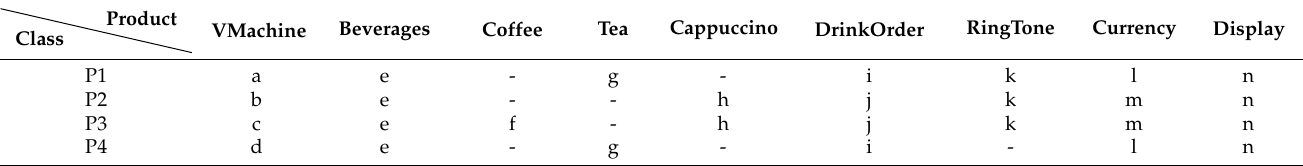
Table 4. The checksum matrix for SPL V0 .